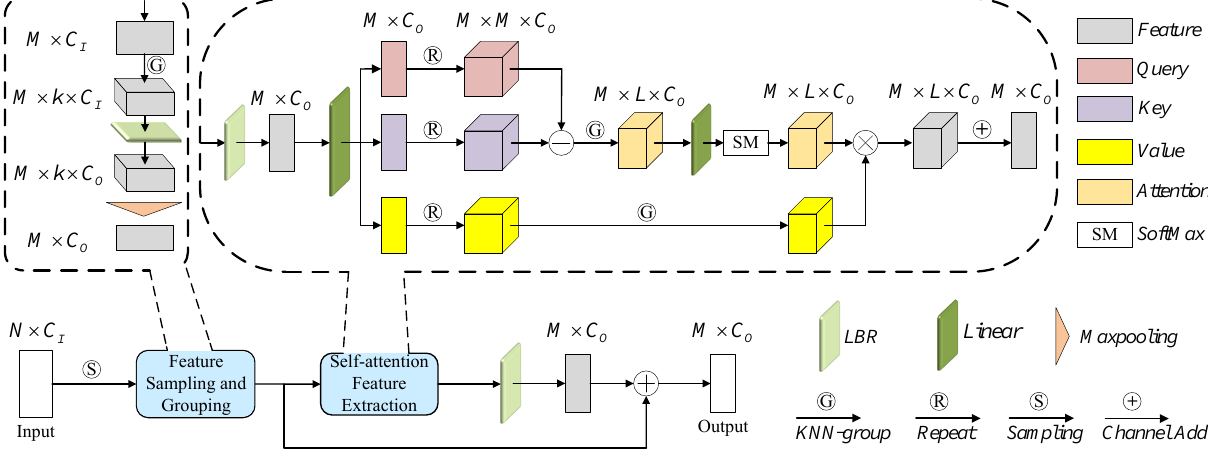
Figure 5. Illustration of PTD. The letters near the box indicate its shape, e.g., N × C, N is the number of points and C is the dimension numbers of features. LBR combines Linear and BatchNorm layers and a ReLU function. KNN-group indicates the grouping operation with k-Nearest Neighbors